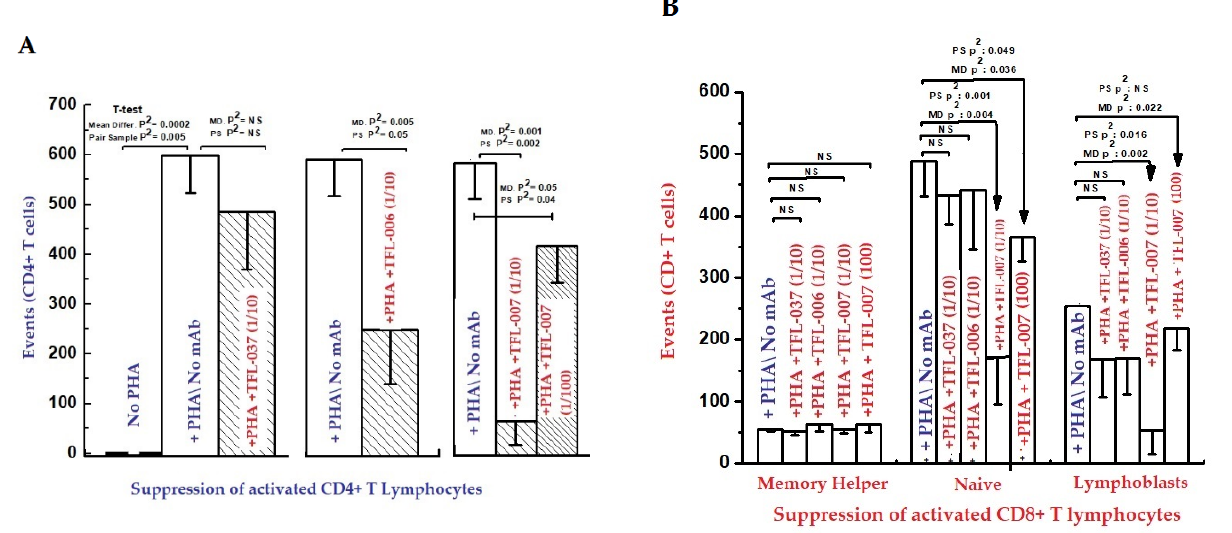
Blastogenesis and proliferation (as measured by carboxyfluorescein succinimidyl ester (CFSE) ‐ la ‐ belled lymphocytes) of phytohaemagglutinin (PHA) ‐ activated CD4+ and CD8+ T lymphoblasts in vitro by Intravenous Immunoglobulin (IVIg) and HLA ‐ I polyreactive monoclonal Abs (mAbs) TFL ‐ 006a and TFL ‐ 007a. The data presented is modified from Ravindranath et al. [113,133]. NS: not sig ‐ nificant .